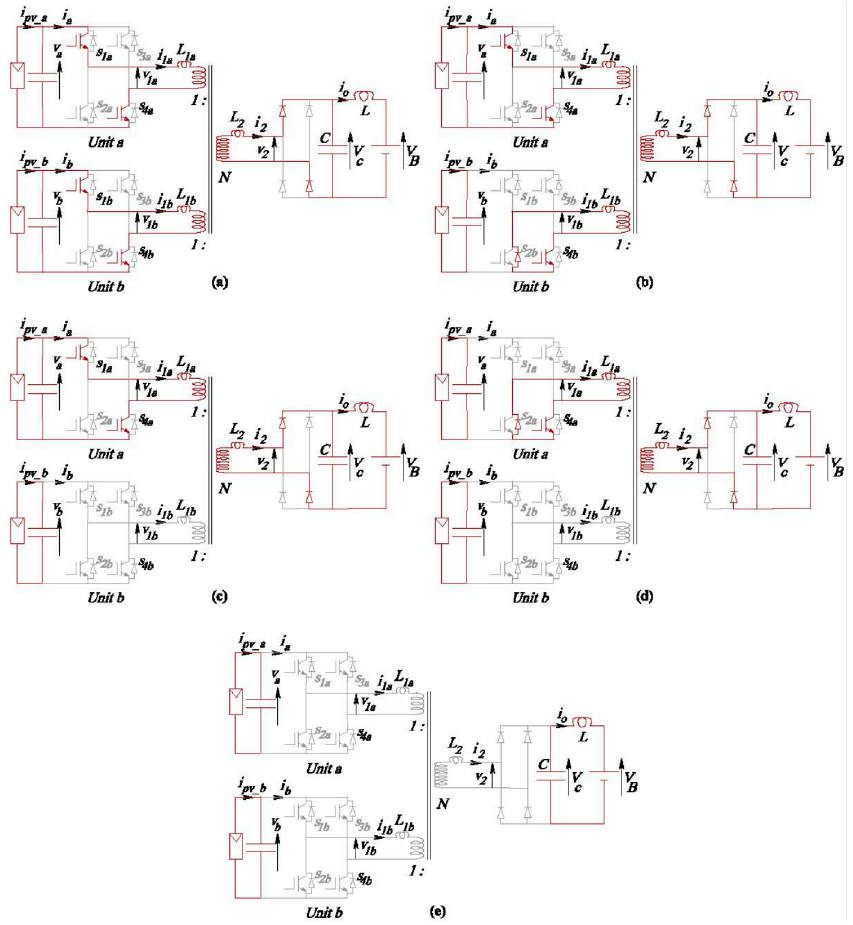
Figure 2. Equivalent circuits for different modes of operation of the proposed interfacing system at the positive half-cycle. ( a ) Mode 1 equivalent circuit, ( b ) Mode 2 equivalent circuit, ( c ) Mode 3 equivalent circuit, ( d ) Mode 4 equivalent circuit, ( e ) Mode 5 equivalent